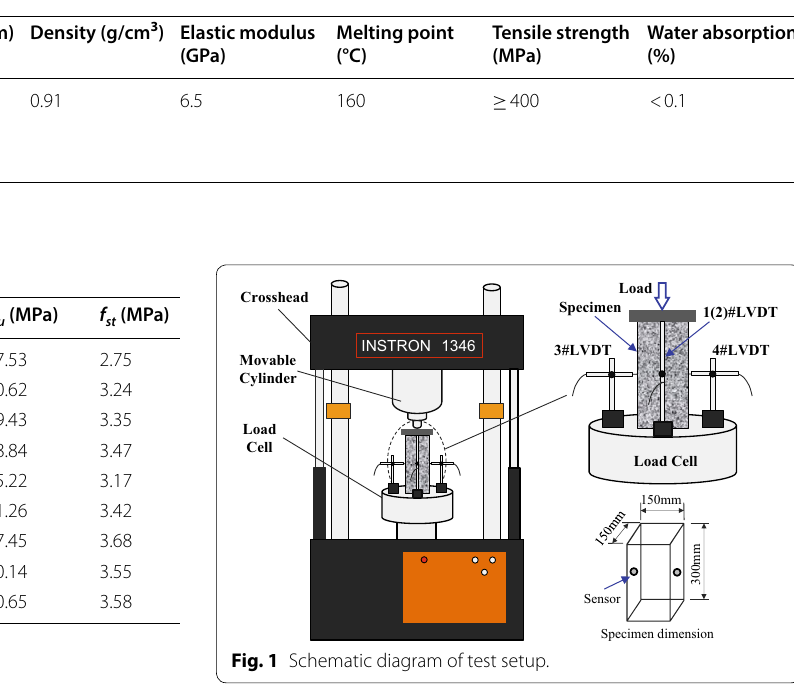
Table 1 Major properties of fibers.